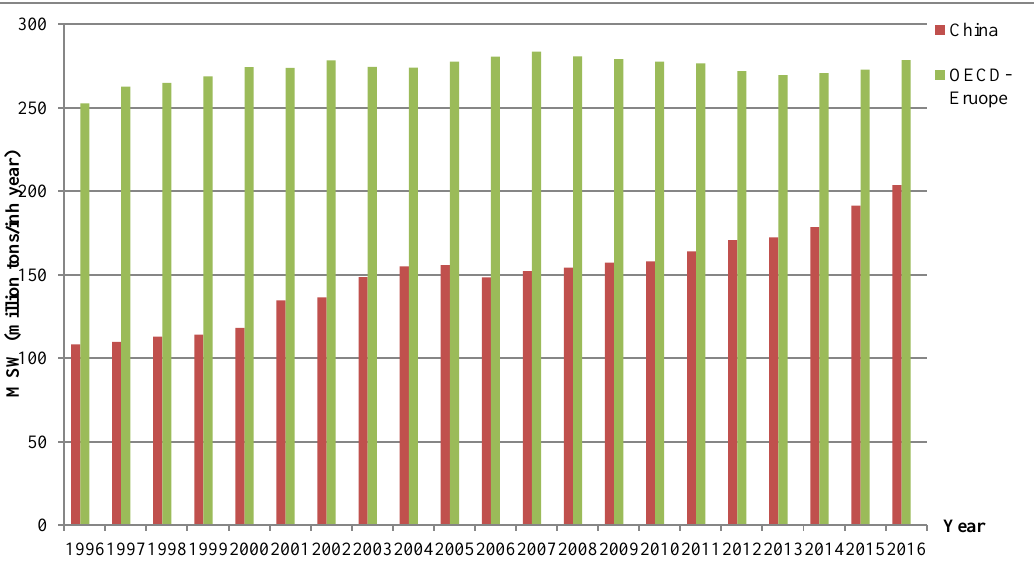
Figure 1. Comparison of municipal solid waste volume in China and Organization for Economic Co-operation and Development countries (Source: OECD statistics, https://stats.oecd.org/).